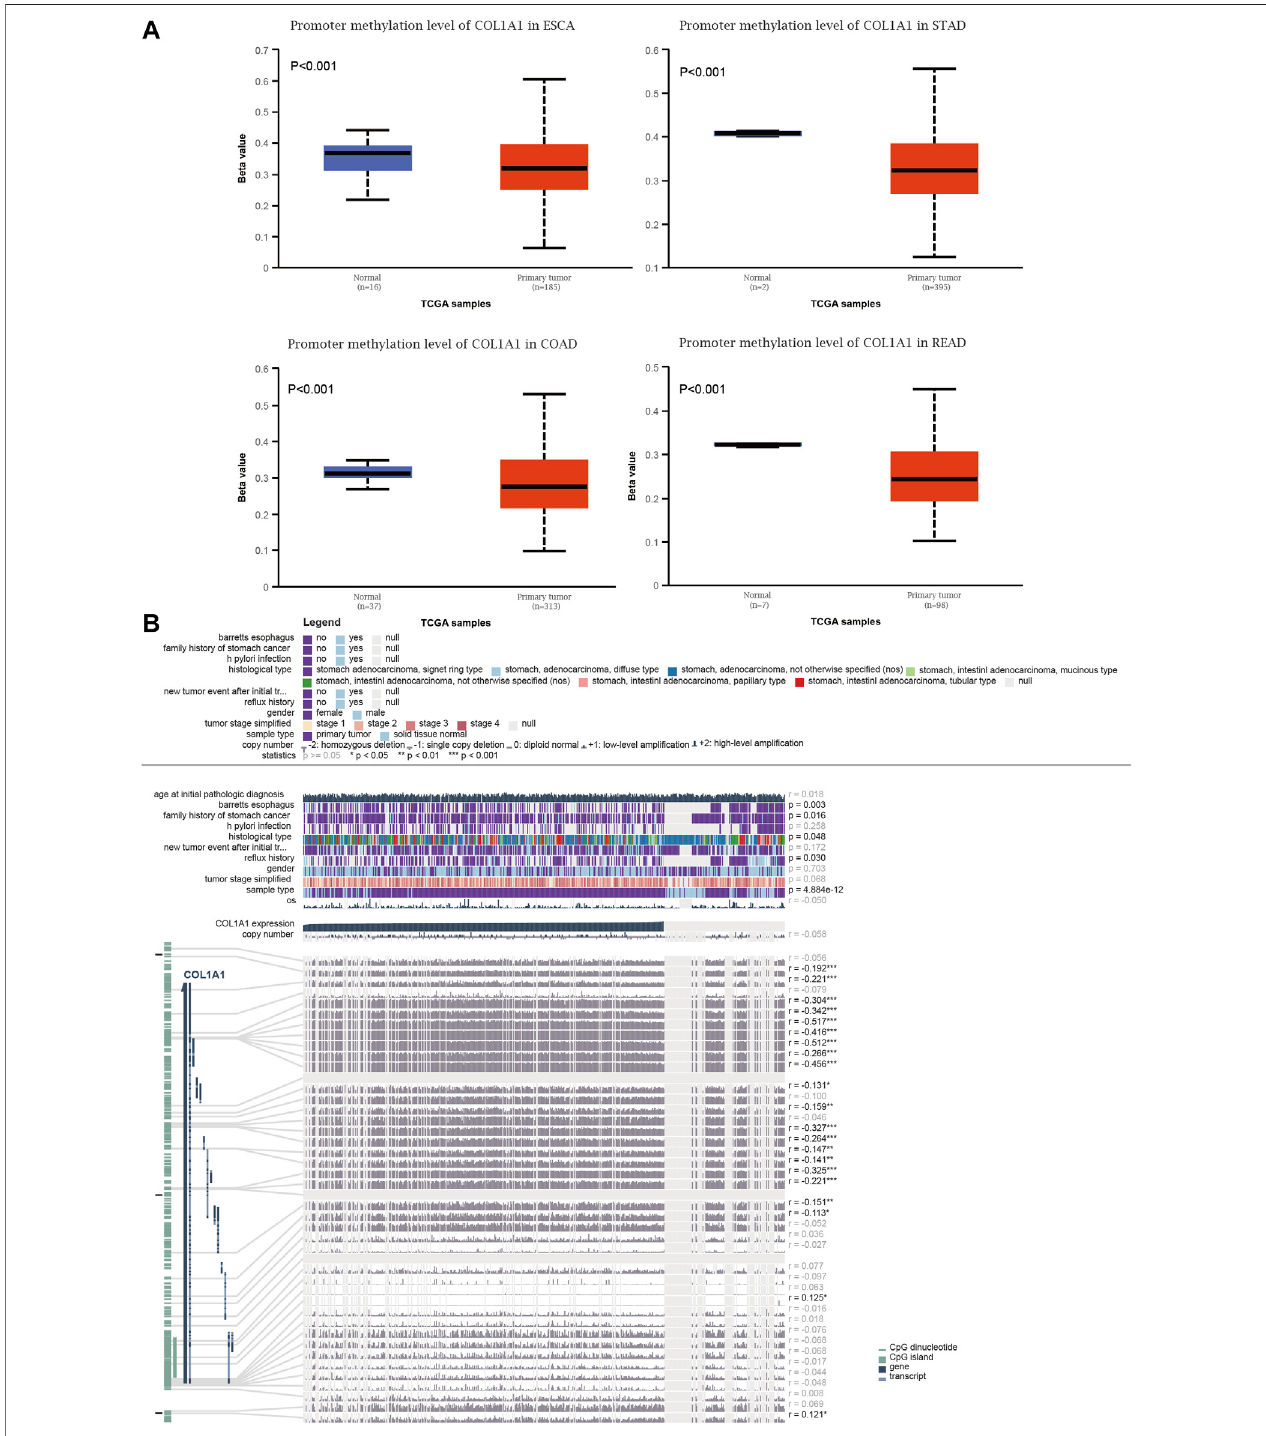
FIGURE 4 | (A) Box plots of the COL1A1 methylation level in normal and gastrointestinal cancers tissues by UALCAN. (B) The detailed information of correlation between COL1A1 expression and DNAmethylation, copy number, and clinical datainSTADby MEXPRESS. Copy number of COL1A1 wasexaminedusing Wilcoxon ’ s rank-sum test and Pearson ’ s correlation analysis. * p < 0.05, ** p < 0.01, *** p < 0.001.